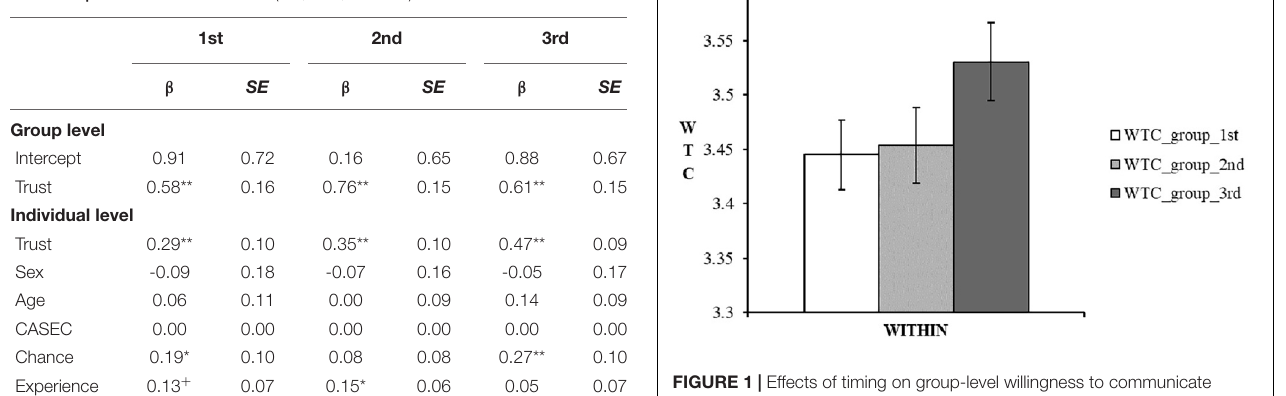
TABLE 4 | Effects of trust on WTC (1st, 2nd, and 3rd).